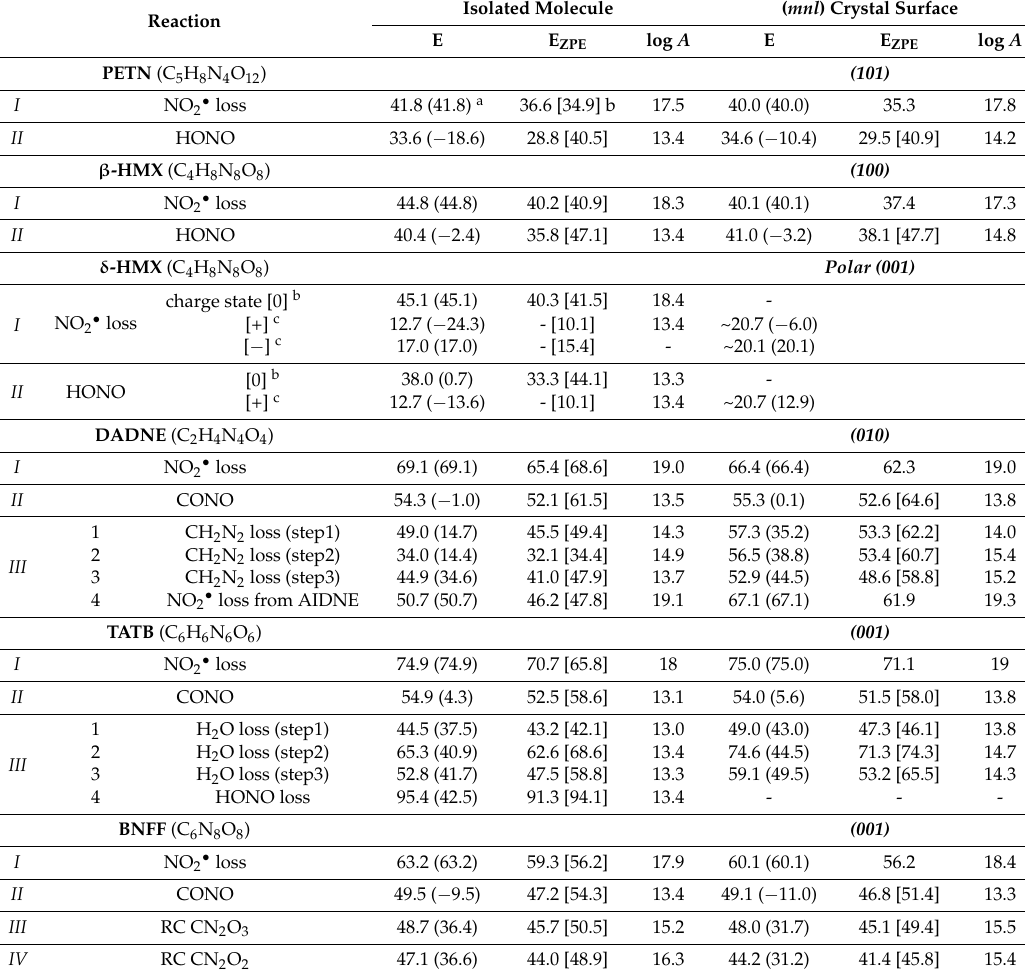
Table 1. The calculated activation barriers E (kcal/mol), zero-point-energy corrected barriers E ZPE (kcal/mol), and pre-exponential factors, log ( A , s ´ 1 ) of thermal decomposition of PETN, HMX, DADNE, TATB, and